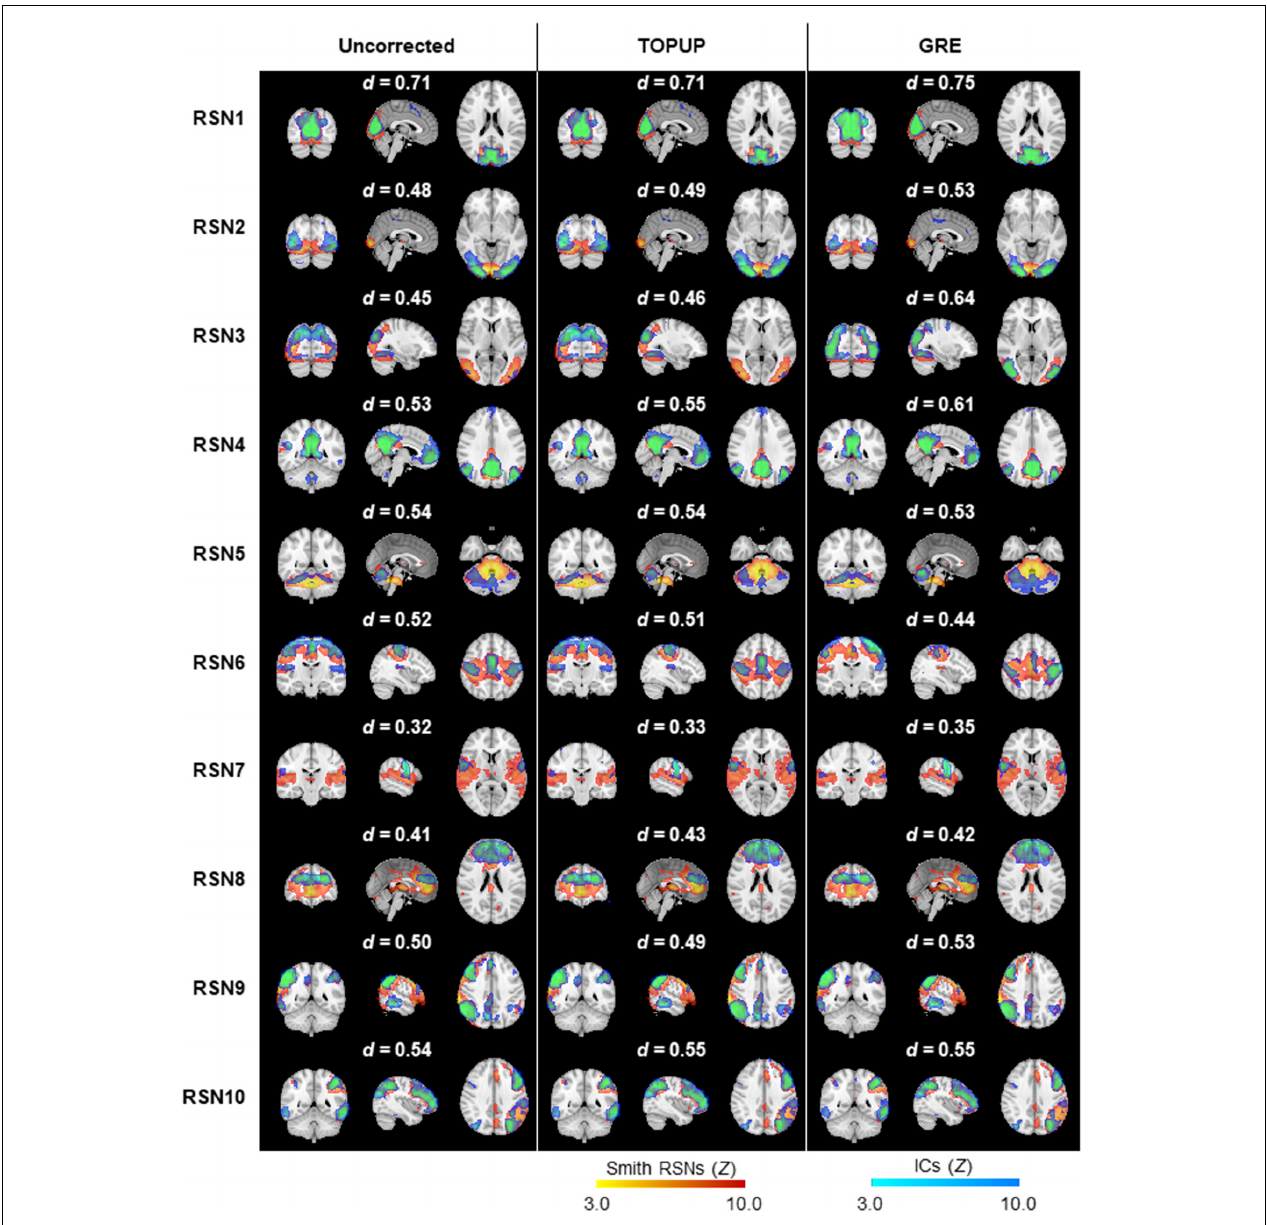
FIGURE 6 | Ten group RSNs identified on (left) uncorrected, (middle) TOPUP corrected, and (right) GRE-corrected fMRI data for the first run of the biological motion perception task. The RSN templates (in red–yellow) from Smith et al. (2009) are superimposed with the spatial independent components (in blue–light blue) selected for each RSN template, according to their Dice coefficient (also shown above each